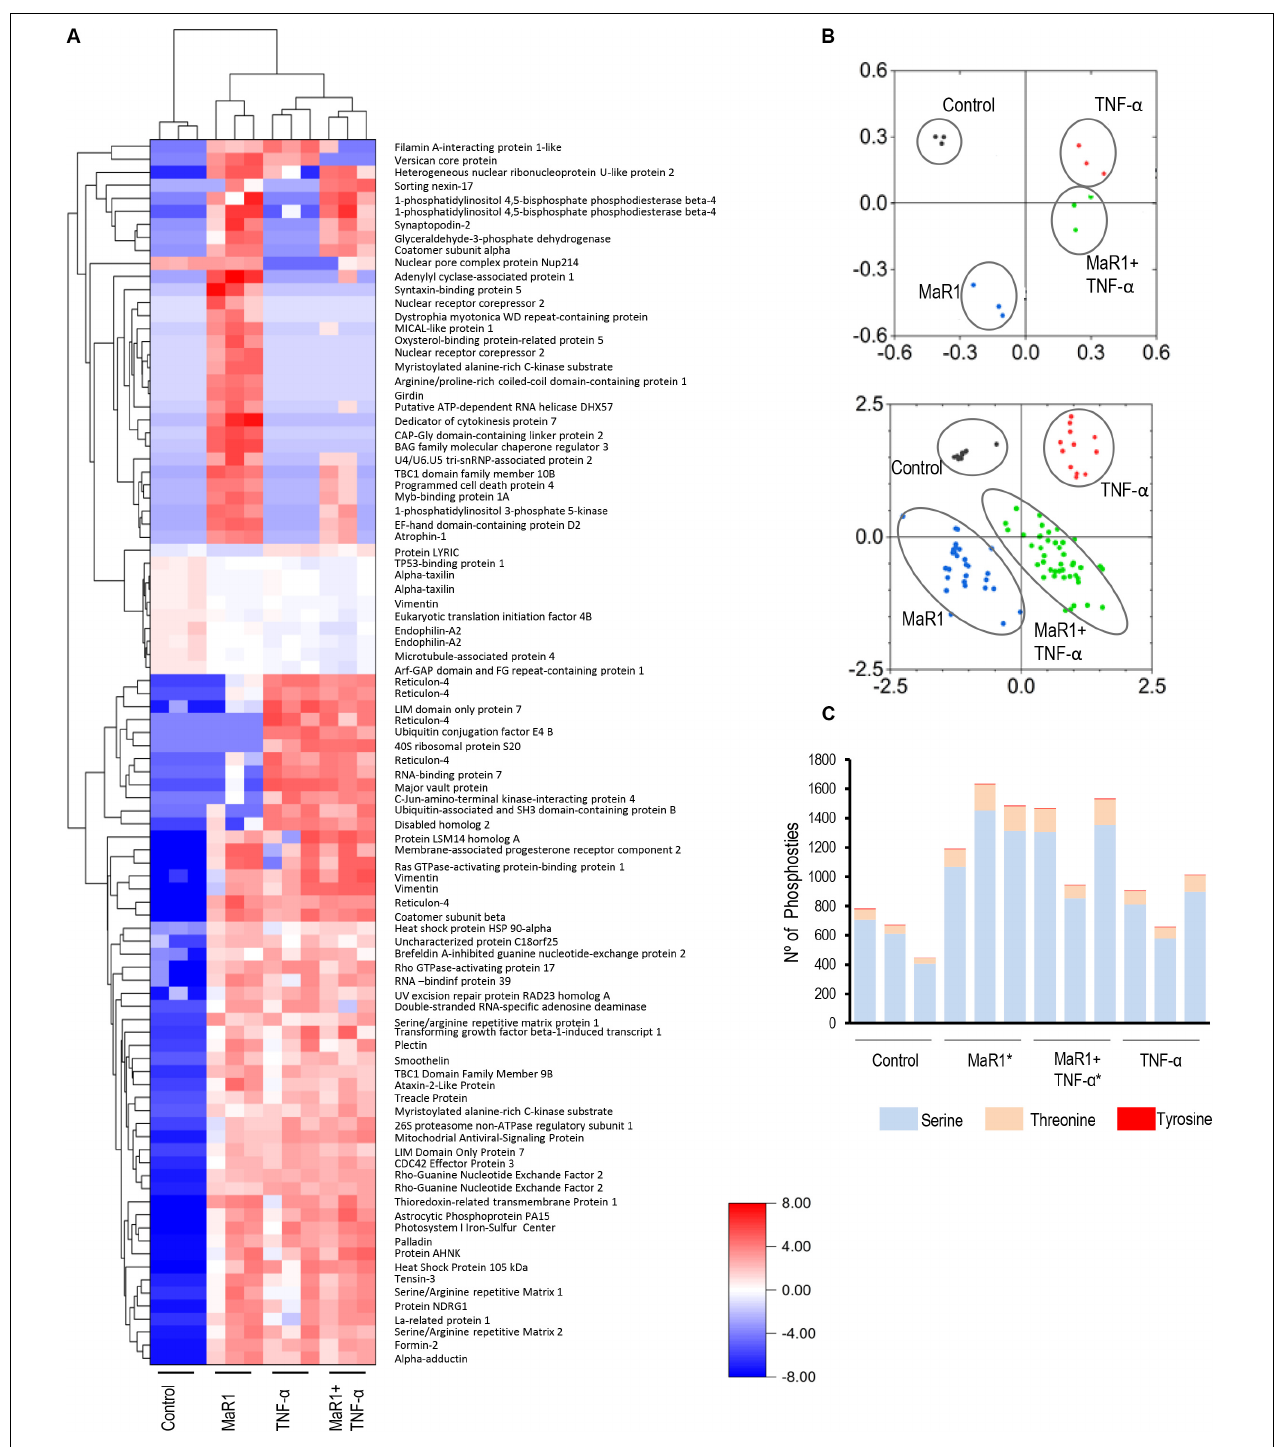
FIGURE 5 | Identification and quantification of protein phosphorylation in control and the presence of MaR1, TNF- α , and MaR1/TNF- α . For each of the four experimental conditions, the phosphoproteome data from three independent biological replicates were collected. All phosphopeptides with FDR-adjusted p -values of ≤ 0.05 (ANOVA) passed the threshold criteria for statistical significance. (A) Hierarchical cluster analysis of the differentially expressed phosphoproteins and log2-fold changes between treatments and control. (B) Principal component analysis (PCA) showing a loading plot that visualizes the clustering of all biological replicates from the respective experimental groups (top) and a score plot that illustrates the grouping of statistically significant phosphopeptides (bottom). (C) Illustration of the total number of serine, threonine, and tyrosine phosphosites that were detectable in each experimental condition in three independent biological replicates. (*) p < 0.05 vs control